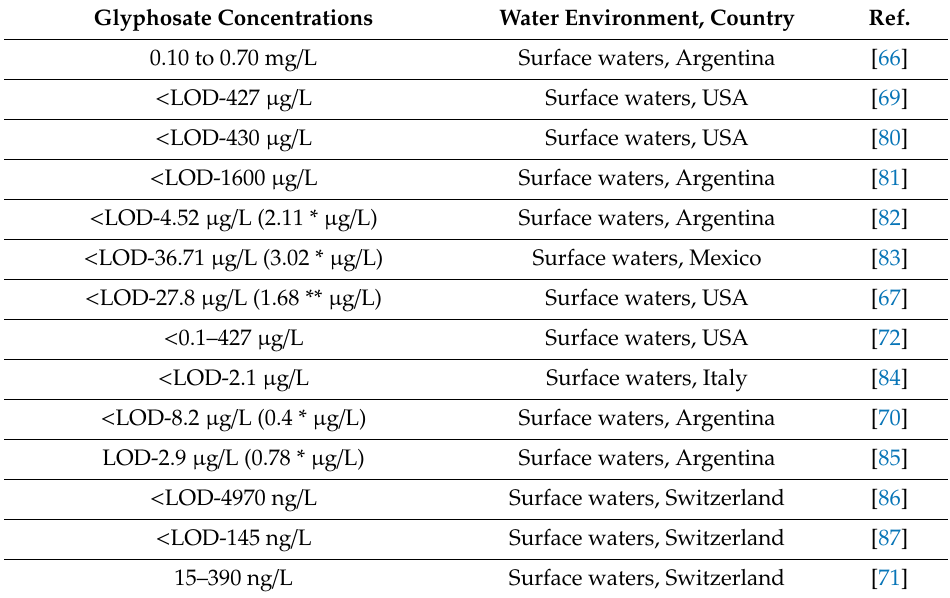
Table 2. Occurrence of glyphosate in water ecosystems. Data are reported as < LOD (limit of detection) up to the highest measured